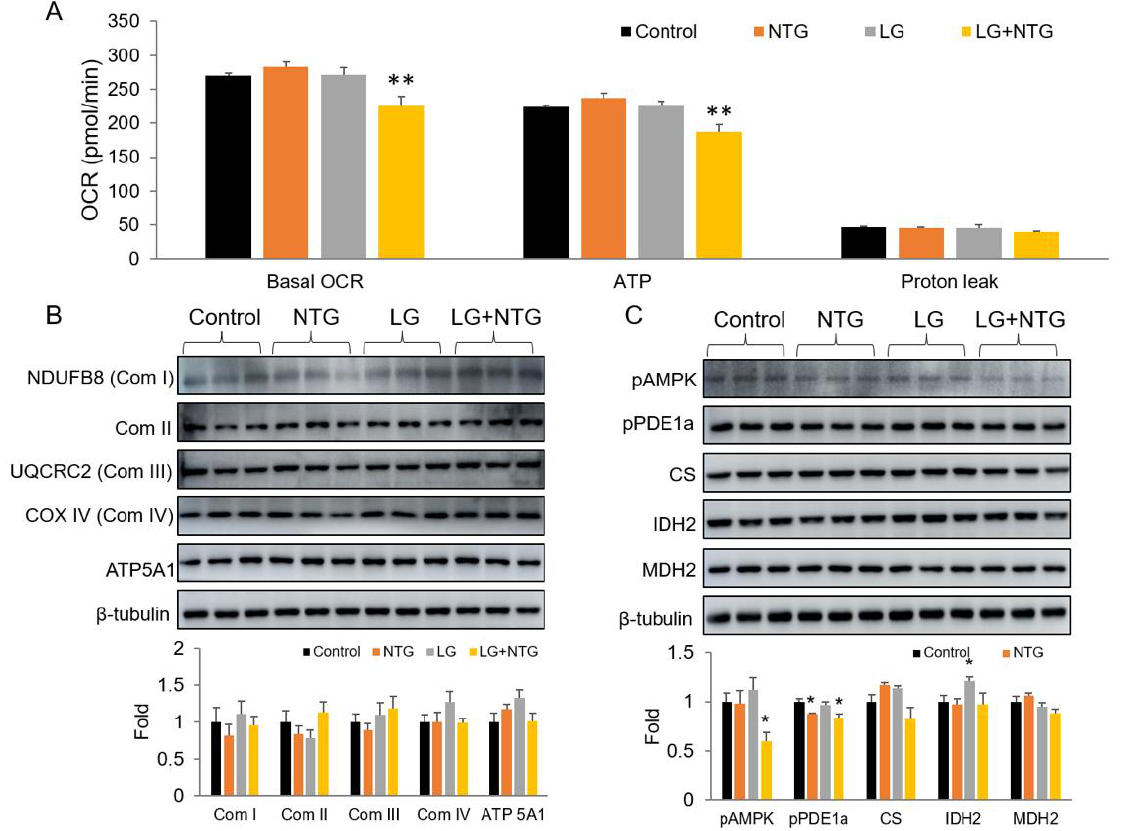
Figure 4. NTG reduced ATP production in low glucose by inhibiting AMPK activity. ( A ) Seahorse was used to detect oxygen consumption rate (OCR). A total of 5 × 10 4 astrocytes were seeded in a well of 24-well plate used in XFe24 Seahorse analyzer. n = 5. Basal OCR and OCR for ATP production and proton leak were calculated with the instruction of Seahorse. ( B ) Proteins of mitochondrial com- plexes underwent no significant change after the treatment of NTG, neither in high-glucose nor in low-glucose conditions. ( C ) Protein level of pAMPK reduced significantly in the low-glucose and NTG group. NTG 2 μ g/mL, treated for 4 h. AMPK, AMP-activated protein kinase; CS, citrate